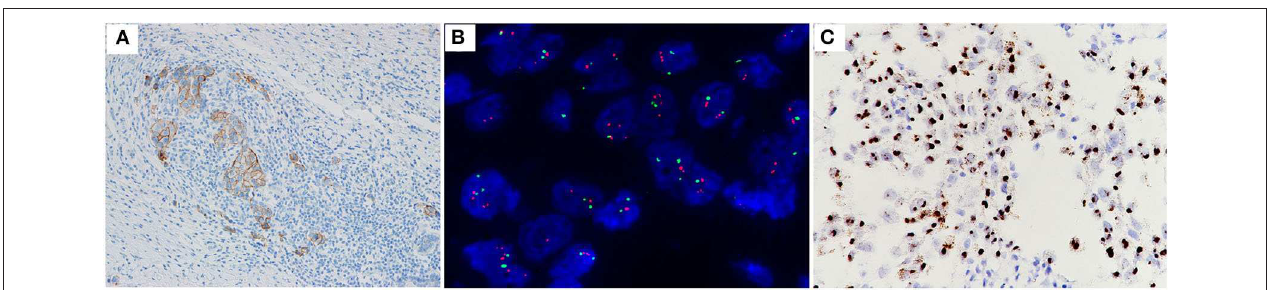
FIGURE 2 | Case no. 31, with IHC2 + (A) , a HER2/CEP17 ratio of 2.06, and an average HER2 signals/cell of 3.70 (B) . Showed high level of HER2 mRNA expression (score 4 by RNAscope, with a cluster signals pattern in tumor, and without any signal in non-tumor cells) (C) .